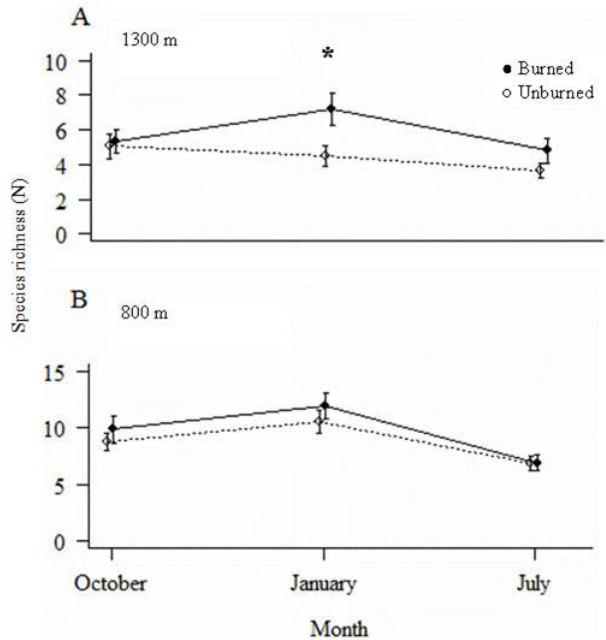
Fig 2 . Mean number (+ SE) of species per pitfall in burned and unburned plots A) site at 1300 and B) site at 800 m, one (October), four (January) and ten (July) months after fire. * indicates significant difference (p<0.05) in mean number of species per pitfall between burned and unburned